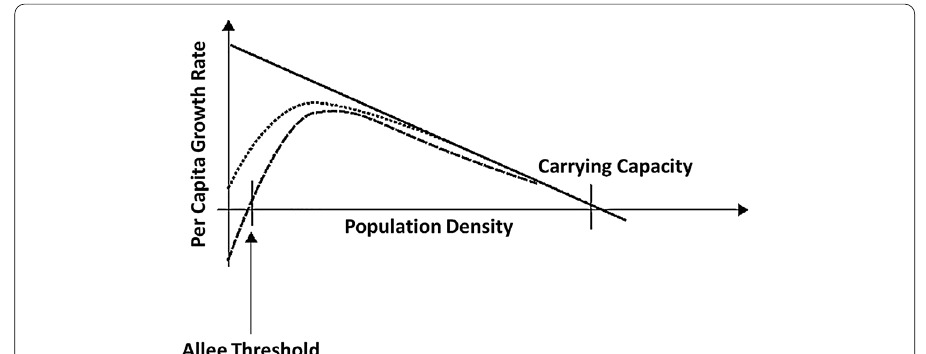
Fig. 1 Classical negative density dependence (solid) compared to strong (dashed) and weak (dotted) Allee effects